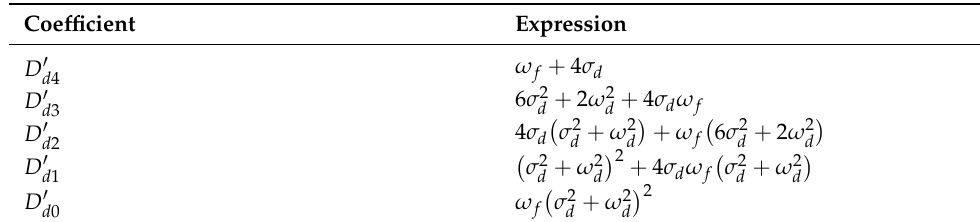
Table 7. Desired fifth–order polynomial